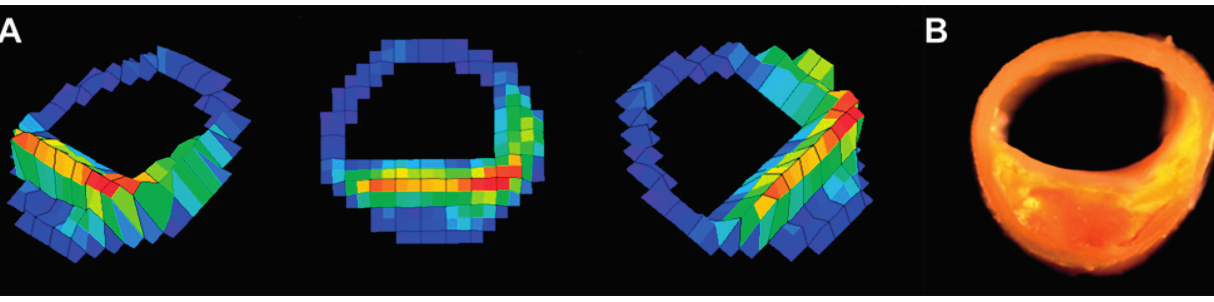
Figure 4. Representative images of carotid plaques. ( A ) Two-dimensional color-coded map of the carotid arterial plaque (red: calcification, yellow and orange: mixed lesion, green: fibrosis, blue and purple: lipid pool); ( B ) Pathological